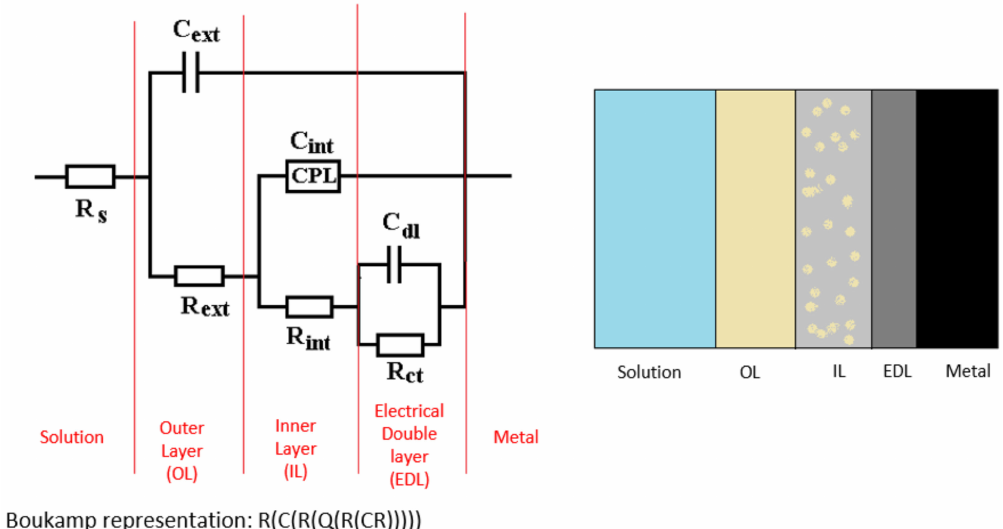
Figure 15. Equivalent circuit, surface physical model, and Boukamp representation for modelling SIE data obtained for samples immersed for 65 days in corrosion